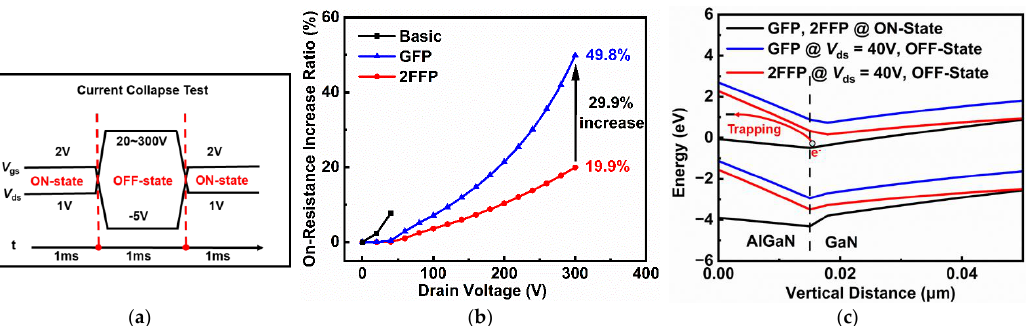
Figure 5. ( a ) Timings and parameter settings in the current collapse measurements, ( b ) relationship between the ON -resistance increase ratio caused by the current collapse phenomenon and the ap- plied voltage as a function of the basic, GFP, and 2FFP structures, and ( c ) conduction/valence band energy of the GFP and 2FFP devices during the ON-state and OFF-state extracted from the upper bound of AlGaN to the lower bound of GaN at the drain-side edge of the gate.